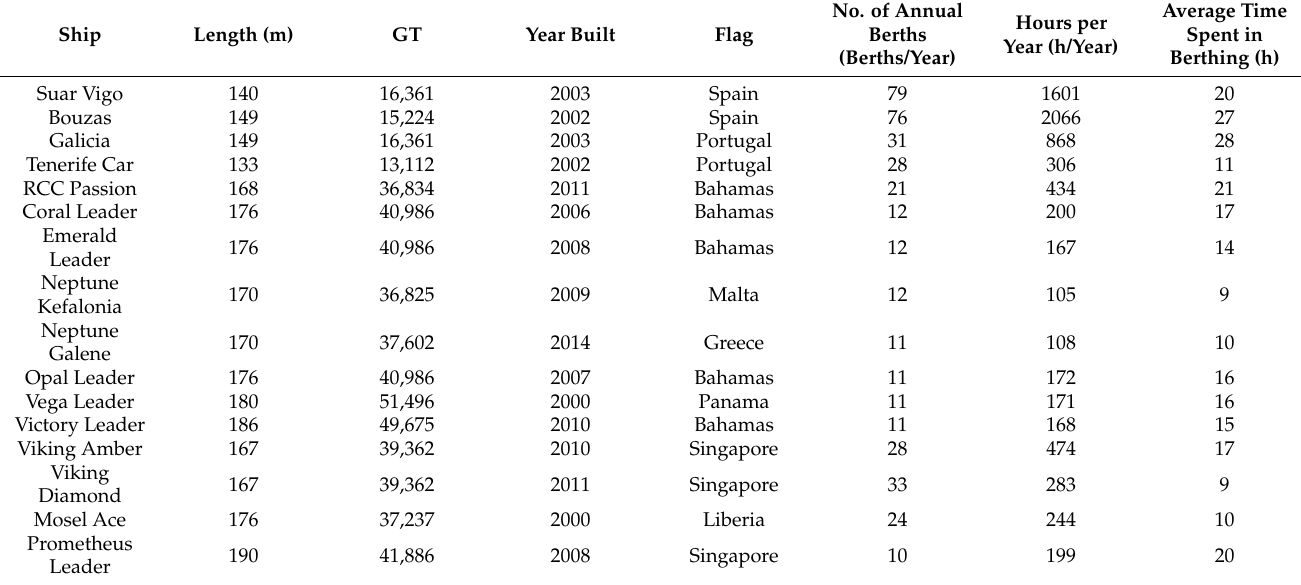
Table 9. Ro–Ro ships selected and initial data.